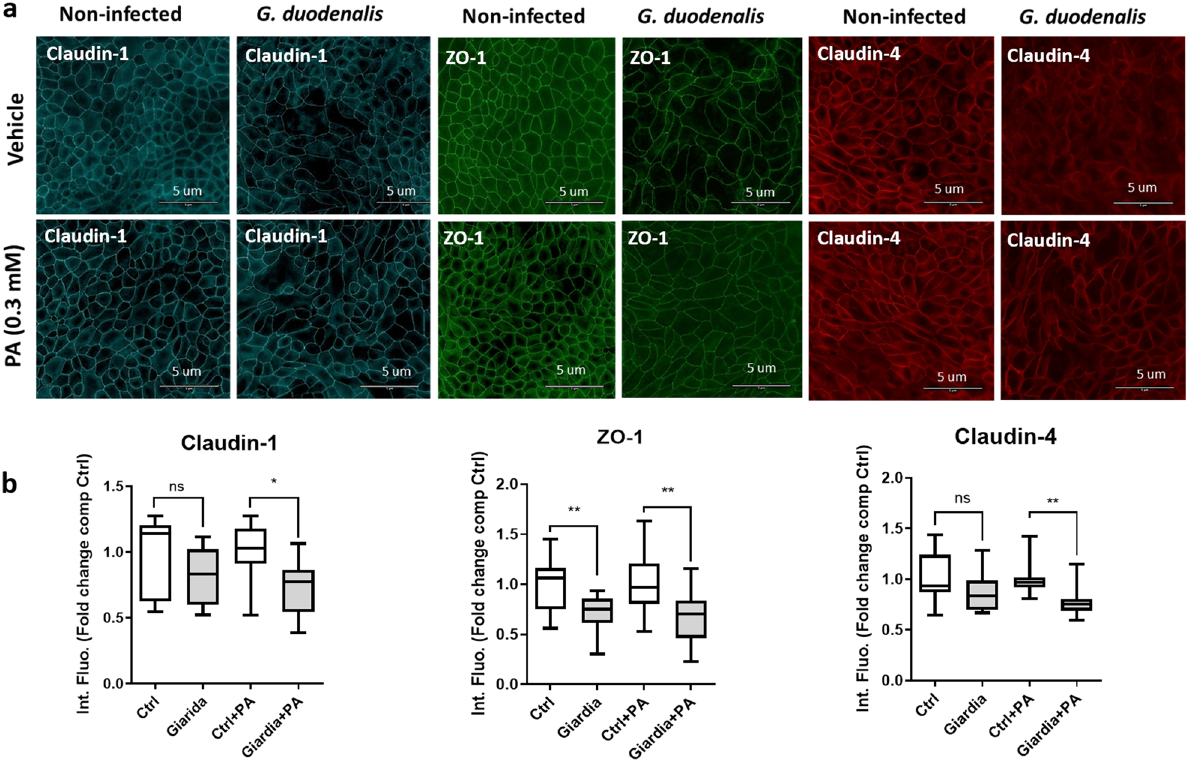
Figure 5. Disruption of tight junction proteins claudin-1 and claudin-4 by Giardia is enhanced in the presence of palmitic acid in SCBN cells. Intestinal epithelial cells (SCBN) were pre-treated with vehicle (Ctrl) or palmitic acid (PA; 0.3 mM) and challenged for 24 h with G. duodenalis isolate GS/M ( Giardia + PA; MOI = 10:1) or left un-infected (Ctrl + PA). ( a ) SCBN cells were probed for immunofluorescence staining of ZO-1, claudin-1 and claudin-4 proteins (scale bar = 5 μm). ( b ) ZO-1, claudin-1 and claudin-4 relative protein levels were quantified by fluorescence intensity compared with DAPI (ImageJ) and expressed as fold change compared to Ctrl group. n = 4 per group. Data are expressed as box plots with min/max whiskers.* p < 0.05, ** p <